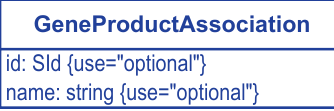
Figure 8: A UML representation of the Flux Balance Constraints package GeneProductAssociation class. For a com- plete description see Figure 1 as well as Section 1.4 for conventions related to this